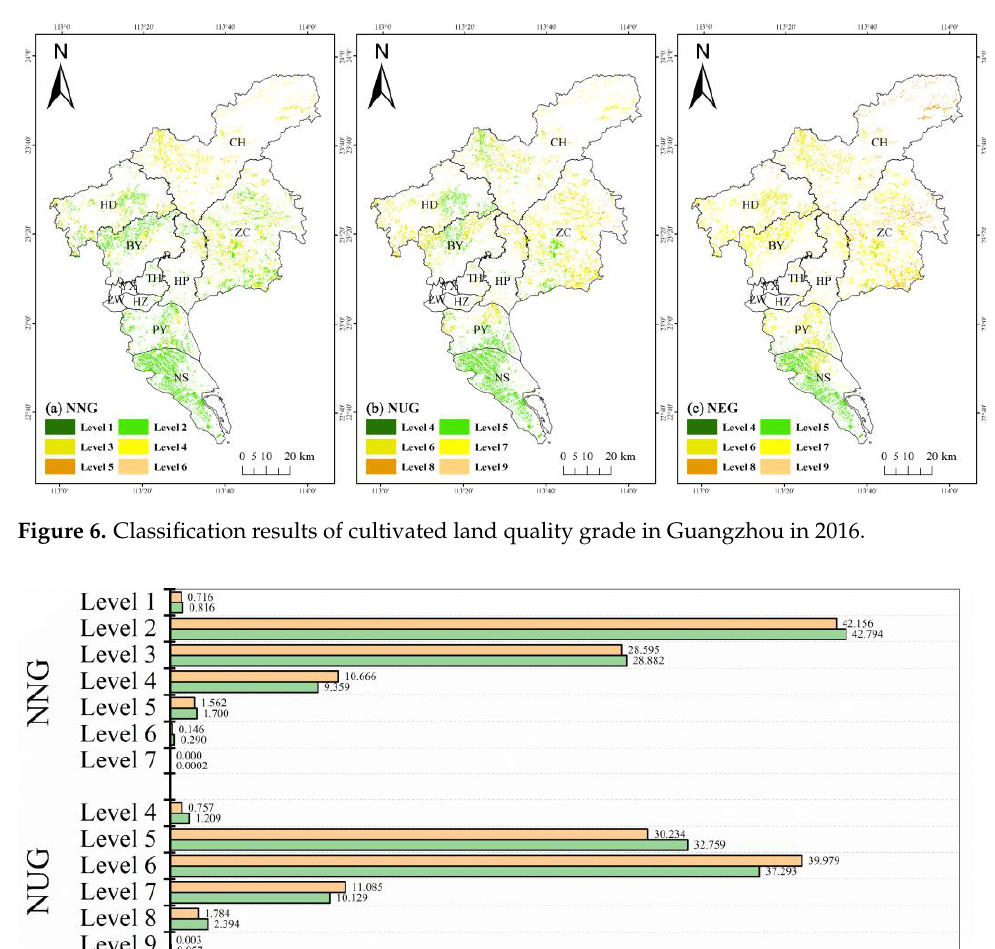
Figure 8. Gap in the quality of cultivated land grade: (a) NNG gap, (b) NUG gap, and (c) NEG gap.